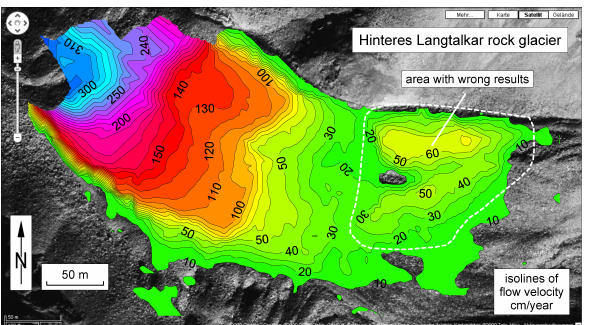
Figure 4. Isolines of mean annual horizontal flow velocity of Hinteres Langtalkar rock glacier derived from image data of Google Maps (epoch 2002) and Microsoft Bing Maps (epoch 2006). GSD: 40 cm, grid spacing: 12 × 12 pixel, template size for image matching: 25 × 25 pixel, 4402 valid points, precision 3.37 m/year. Image data shown: © Google Maps, 2012.